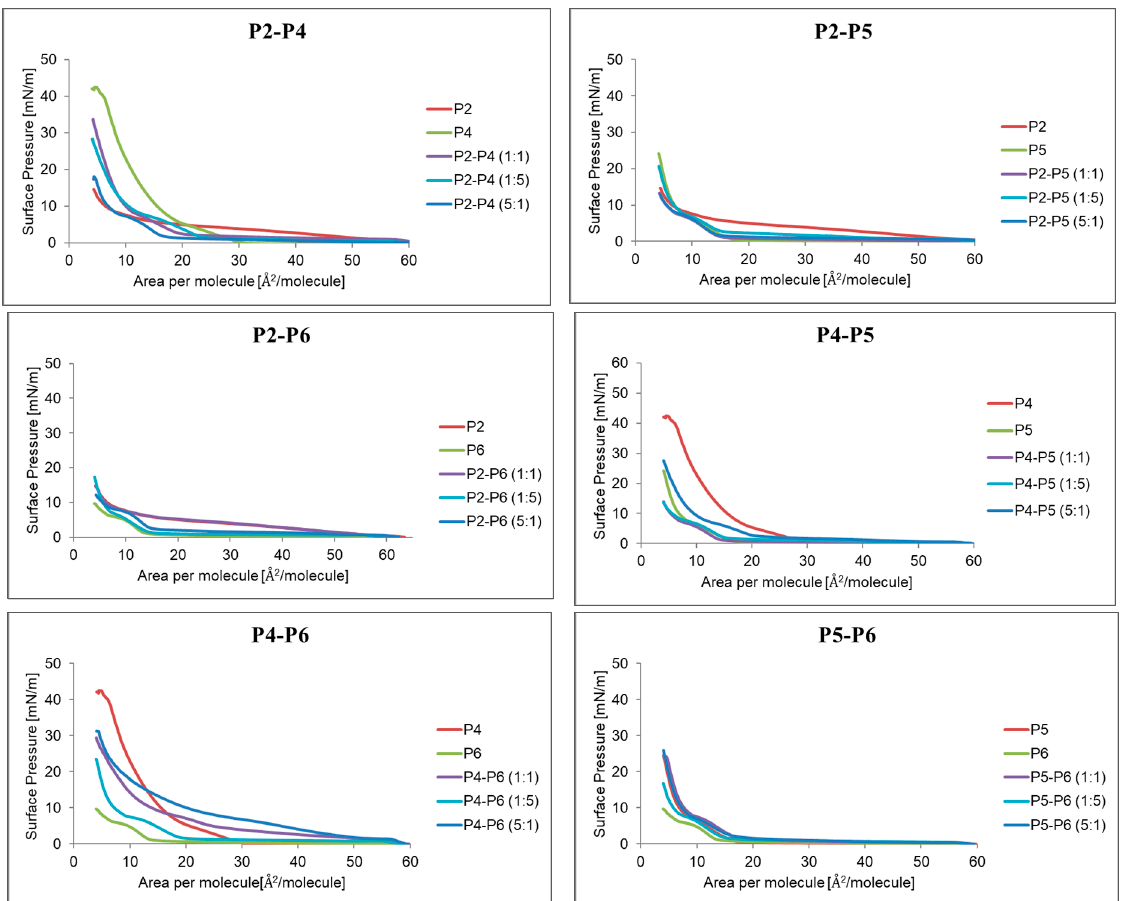
Figure 6. Isotherm of compression of a monolayer formed from a mixture of compounds P2, P4–P6 in different proportions on the surface of a pure liquid phase.